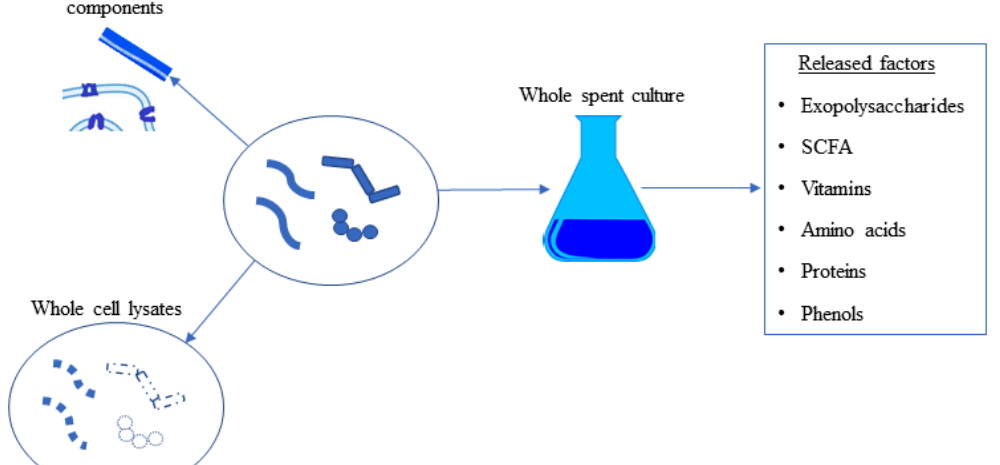
Figure 3. The contents that can be classified as postbiotics. Whole cell lysates include all intracellular and cell membrane/cell wall components. Only cell wall and membrane components can be used as postbiotics. Factors secreted into the extracellular environment, fermentation broth, or spent culture media can be considered postbiotics. SCFA: Short-Chain Fatty Acids.